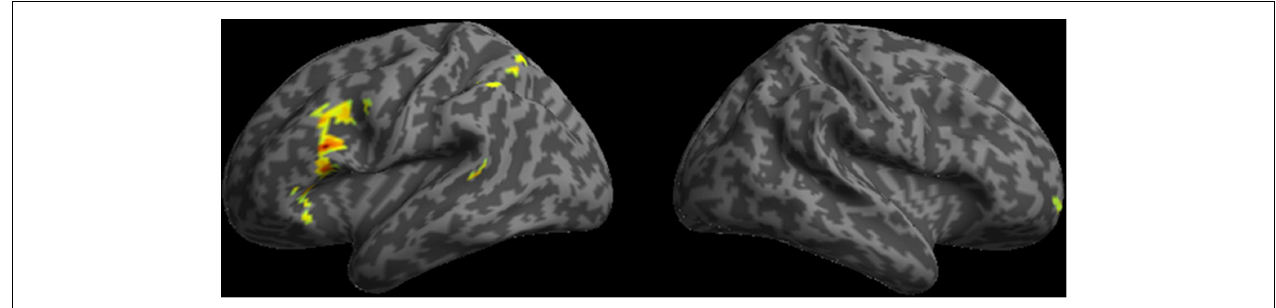
FIGURE 3 | Regions of activation observed in whole-brain analysis for ambiguous doubly-quantified sentences minus baseline unambiguous sentences.